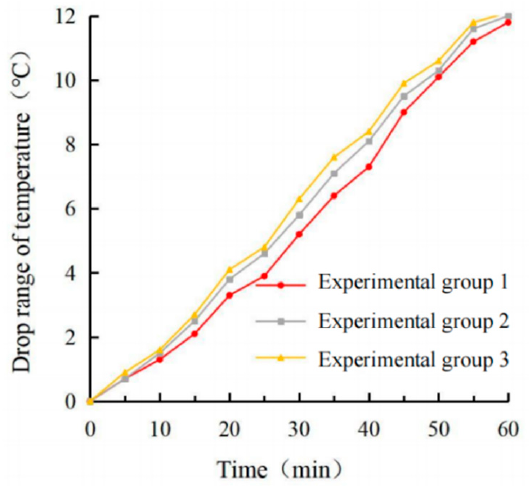
Figure 16. Internal cooling value diagram.